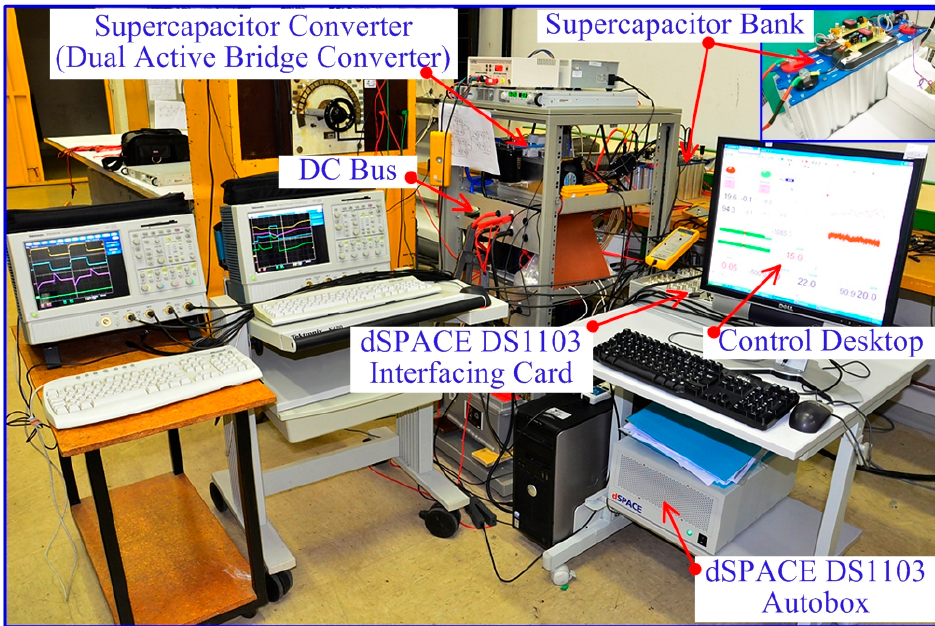
Figure 14. Real-time laboratory test bench.